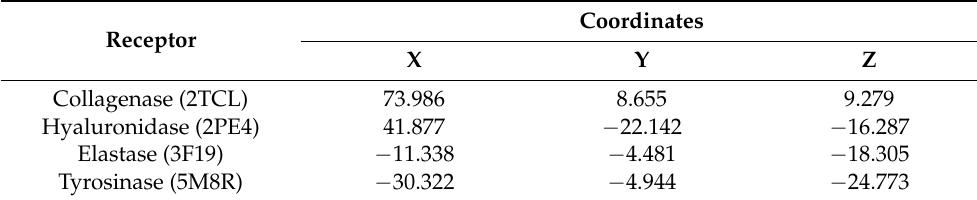
Table 1. Active site coordinates of the receptor.